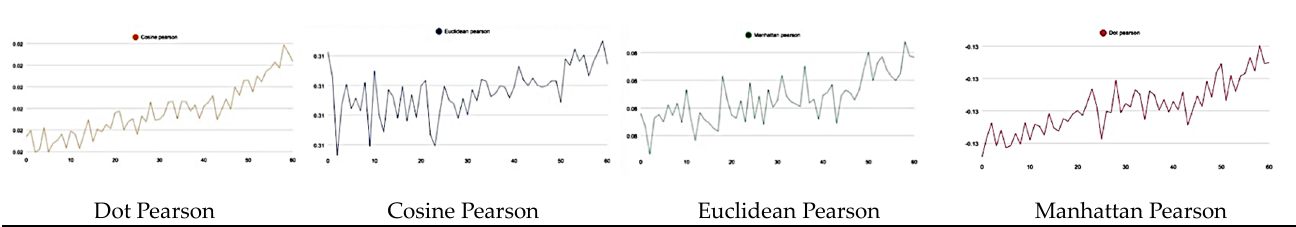
Figure 14. Cosine, Euclidean, Manhattan, and Dot Pearson correlation values calculated at 60